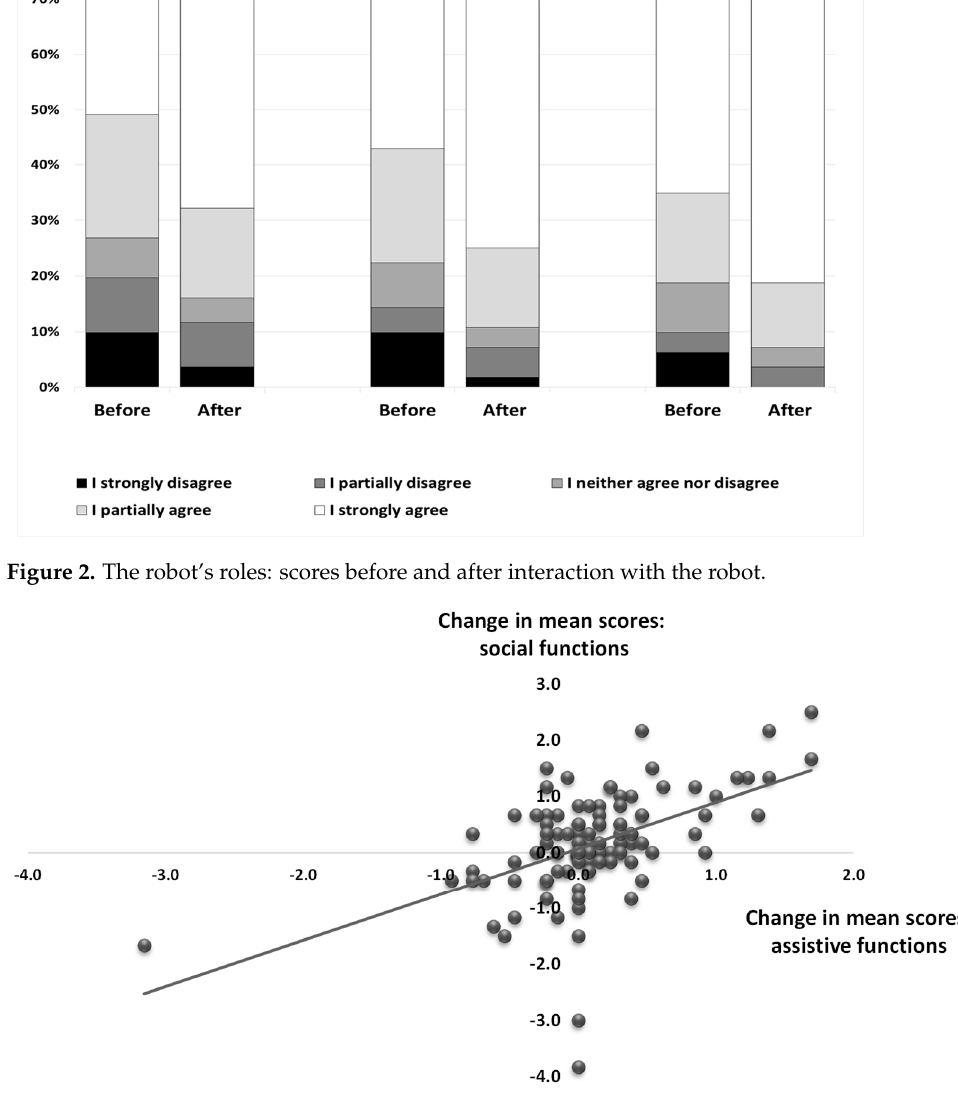
tive Figure 3. Correlation between opinion changes (before and after interaction) for social and assis ‐ tive functions.